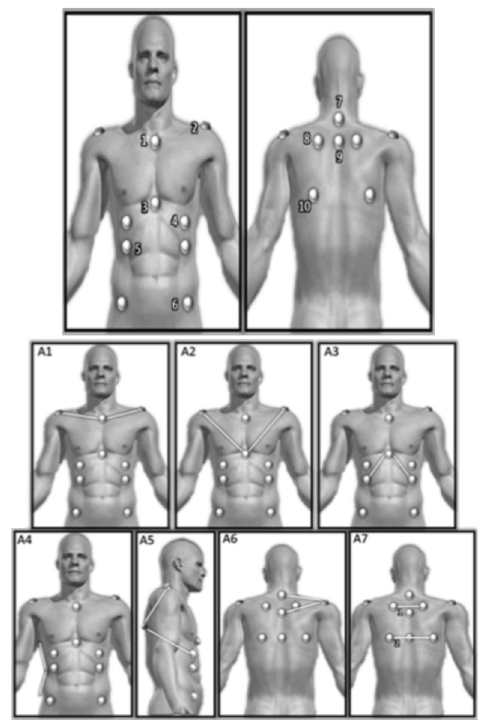
Figure 1 - 1. Manubrium of sternum; 2. Acromion of the scapula; 3. Xiphoid process of sternum; 4. Inframammary region (half the distance between nipple and last false rib); 5.Last false rib (intersection of nipple line with last false rib); 6.Antero-superior iliac spine (ASIS); 7. C7 spiny process; 8. Upper angle of the scapula; 9.T3 thymus proces; 10. Lower angle of scapula. A1. Right (R) acromion/manubrium/left (L) acromion; A2. R acromion/xiphoid process/L acromion; A3. R Last false rib/xiphoid process/L last false rib; A4. Side deviation of the trunk; A5. Acromion/lower angle of scapula/ inframammary; A6. C7/acromion/T3; A7. Intersection of segments 1 and 2.